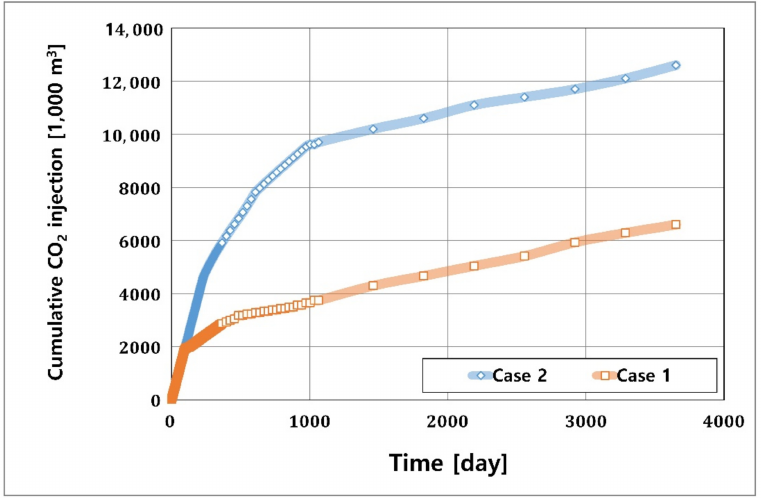
Figure 11. Cumulative CO 2 injection volume at depths of 778 m (Case 1) and 738 m (Case